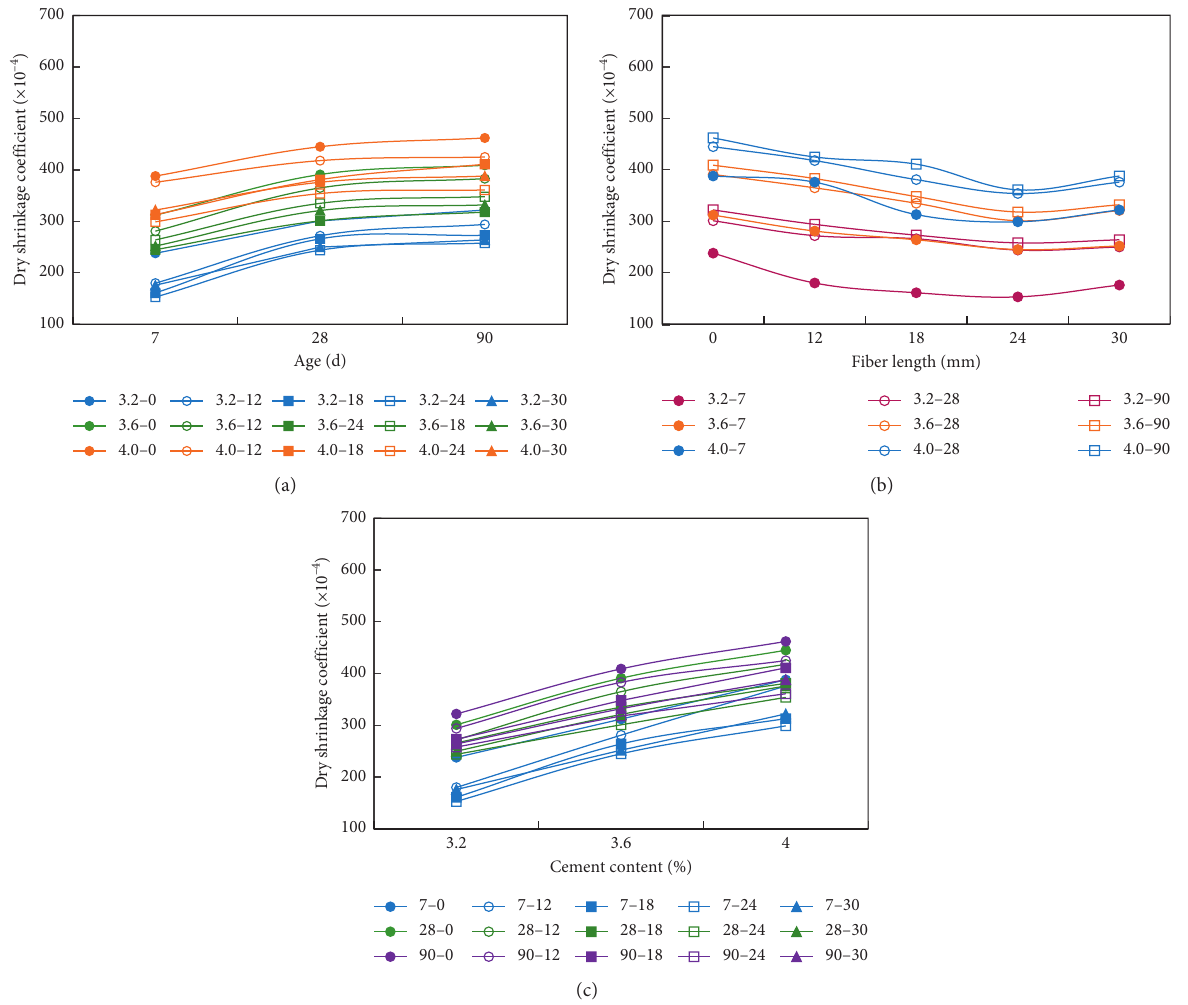
Figure 17: Trend chart of DSC of PFRC: (a) age, (b) fiber length, and (c) cement content.